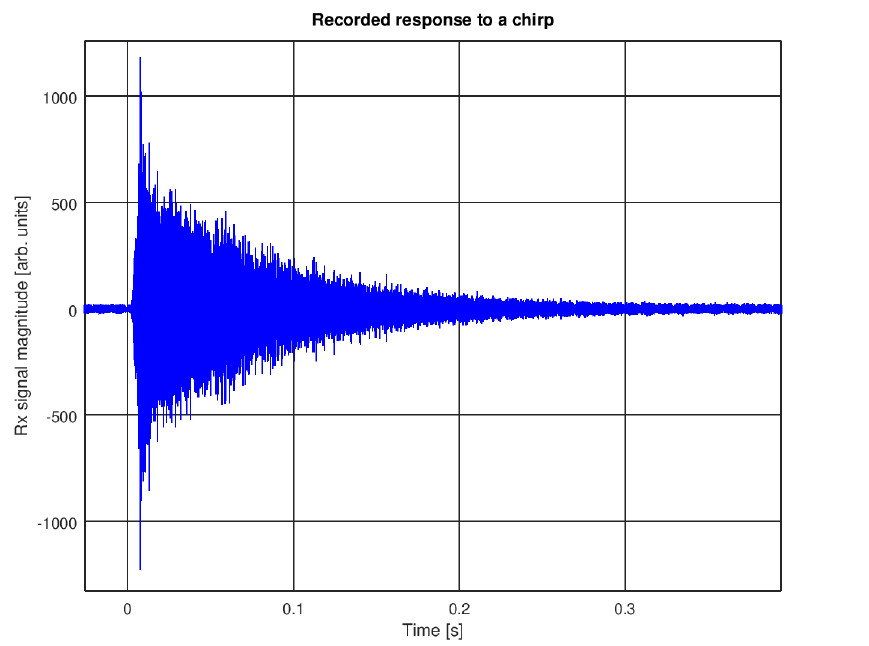
Figure 2. Decay example with chirp signal (garden-type